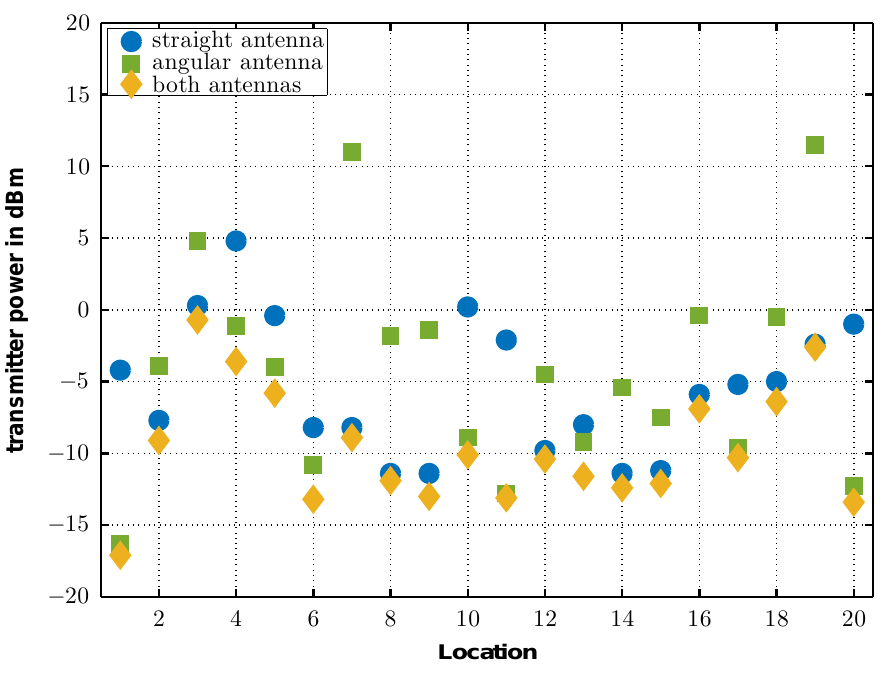
Figure 13. Required power to wake-up the receiver at different